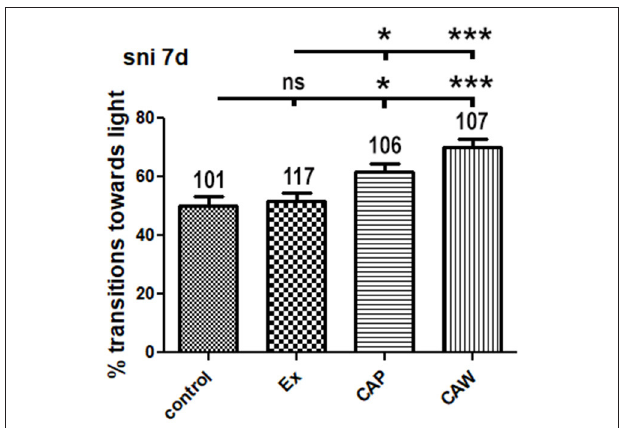
FIGURE 6 | Percentage transitions toward light for sniffer flies treated with Centella asiatica water extract, Centella asiatica water extract product, excipients used in the manufacture of CAP or control food. Drosophila melanogaster fruit flies with a mutation in the sniffer gene sni1 allele were fed standard food (control) or standard food supplemented with either Centella asiatica water extract (CAW; 10 mg/mL), Centella asiatica water extract product (CAP; equivalent to CAW 10 mg/mL), or the matching placebo for CAP containing only excipients (Ex; equivalent to the amount in CAP) for 7 days. Fast phototaxis was performed with flies (data from both sexes combined) and compared to either control or Ex treatment. The number of tested flies is given above the bars and the SEM is indicated. * p < 0.05, *** p <